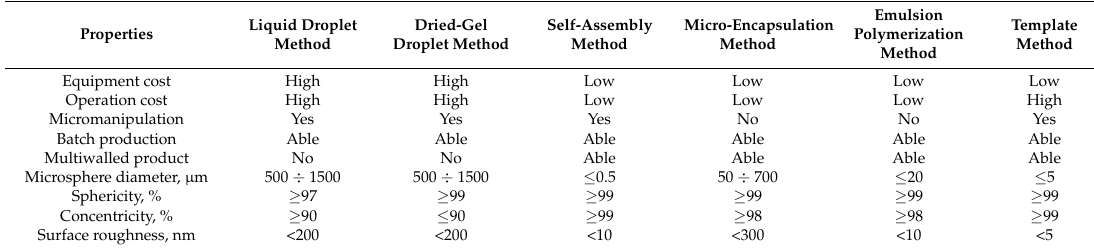
Table 2. Comparison of different methods for preparing polystyrene hollow microspheres. Reproduced